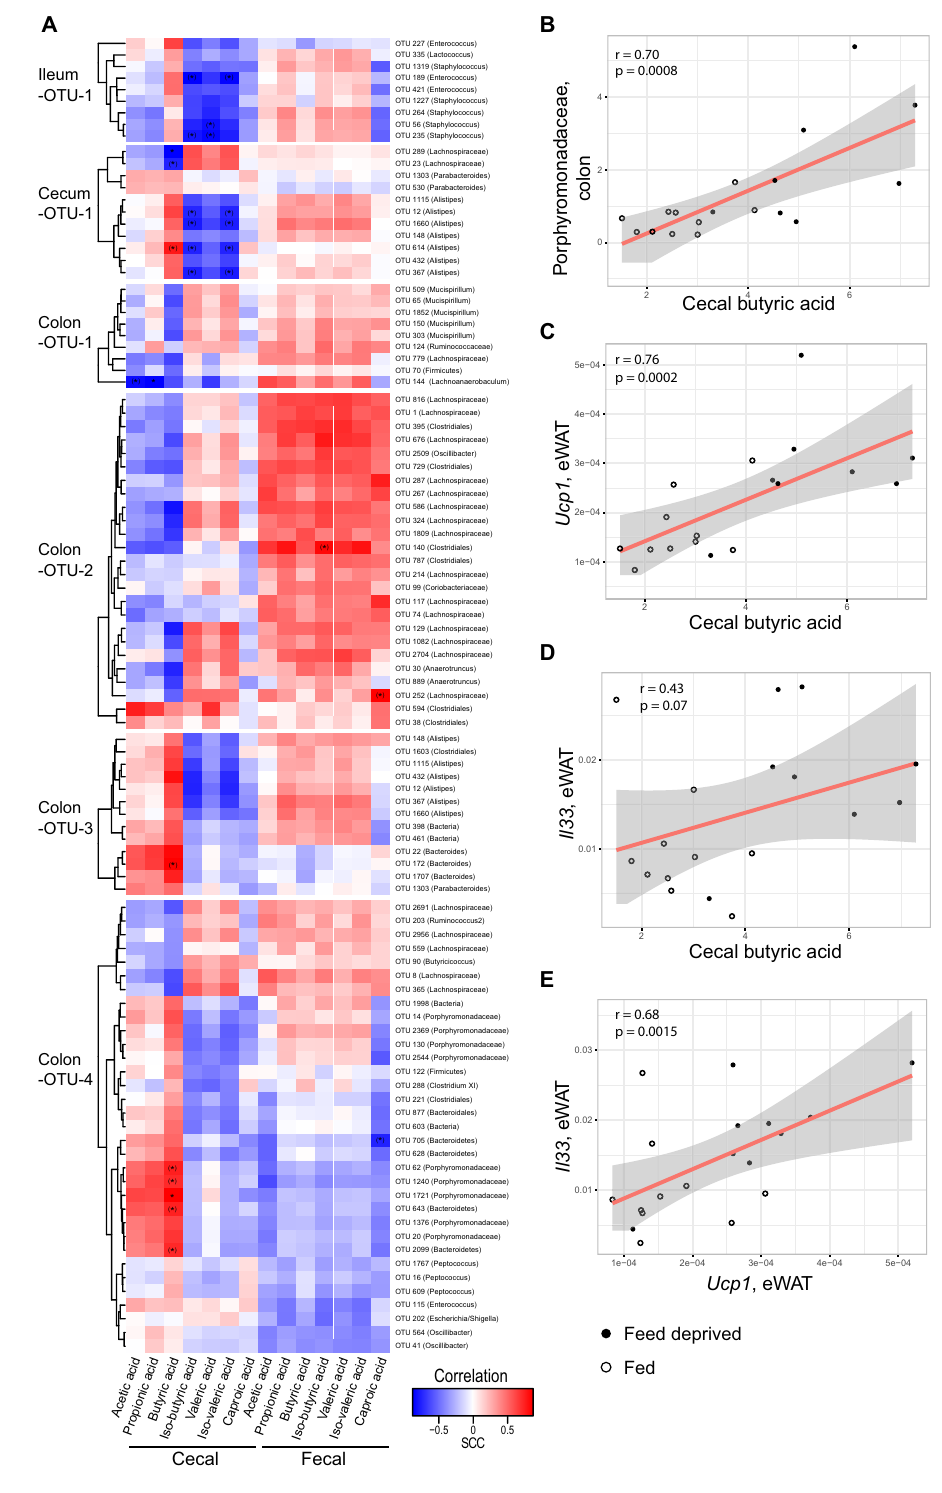
Figure 2. Feed deprivation-induced cecal butyric acid production links to colonic Porphyromonadaceae and adipose tissue expression of Ucp1 . ( A ) Correlation heat map of all OTUs present in the clusters (Ileum-OTU-1, Cecum-OTU-1, Colon-OTU-1 to -4) associated to feed deprivation and measured levels of SCFA and BCFA in cecum and feces. OTUs were hierarchically clustered within each cluster. The heat map color represents Spearman’s rho-values (red, positive rho-values; blue, negative rho-values). Asterisks mark significant correlations (Spearman; *, FDR < 0.05; (*), FDR < 0.1). ( B – E ) Selected correlations related to the cecal butyric acid phenotype. Correlations of butyric acid (μg/mol) and the sum of the relative abundance of all Porphyromonadaceae belonging to Colon-OTU-1 to -4 ( B ), butyric acid (μg/mol) and eWAT Ucp1 (relative expression) ( C ), butyric acid (μg/mol) and eWAT Il33 (relative expression) ( D ), and eWAT Ucp1 (relative expression) and eWAT Il33 (relative expression) ( E ). The red line indicates the parametric linear regression line; grey area is the 95% confidence interval (fed mice, open circles; feed deprived mice, closed